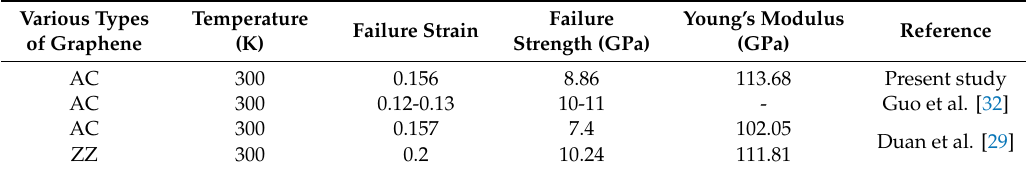
Table 3. The results of previous work compared with the three mechanical values of graphene / copper layered composites in this